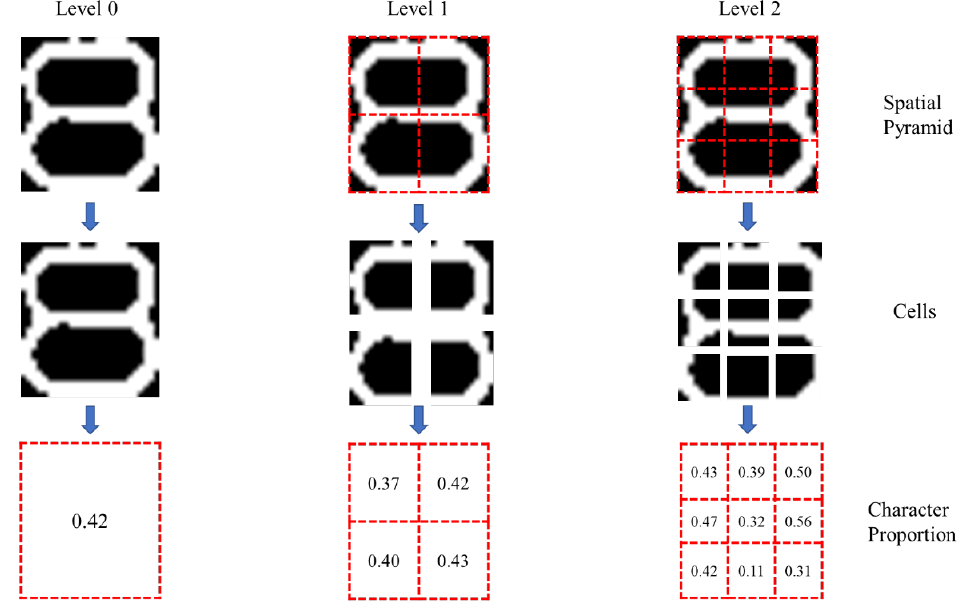
Figure 16. An instance of Spatial Pyramid Character